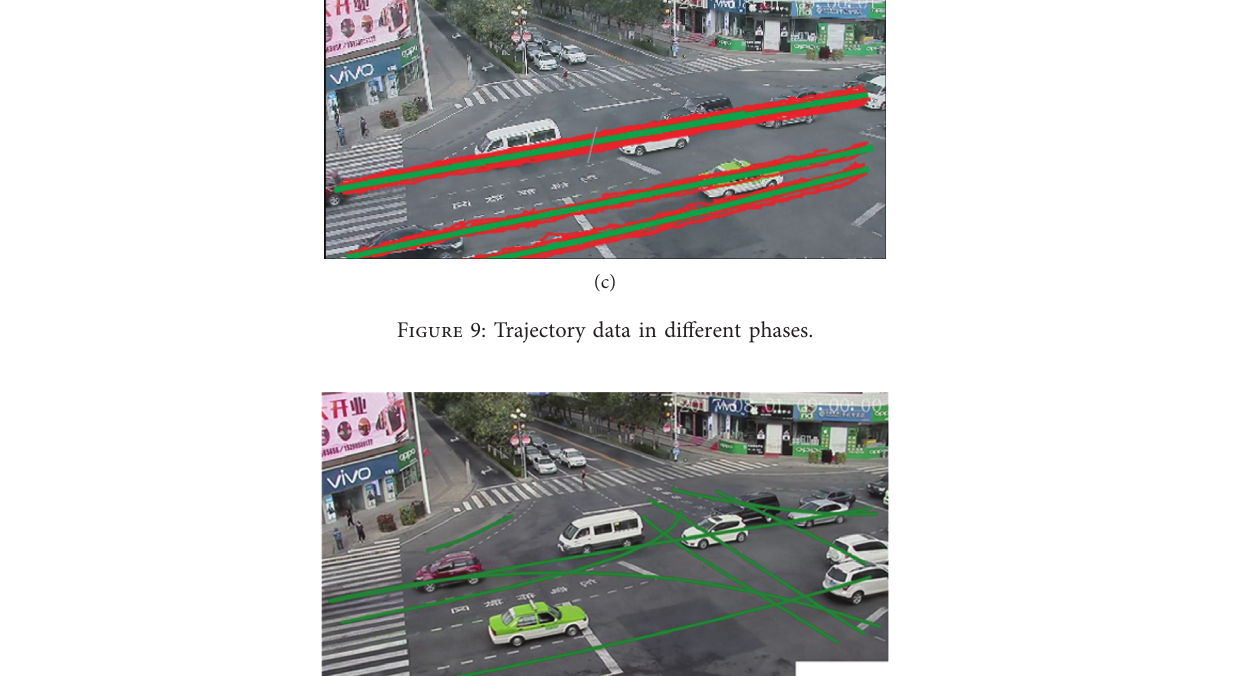
Figure 10: Recognized lanes in an intersection.